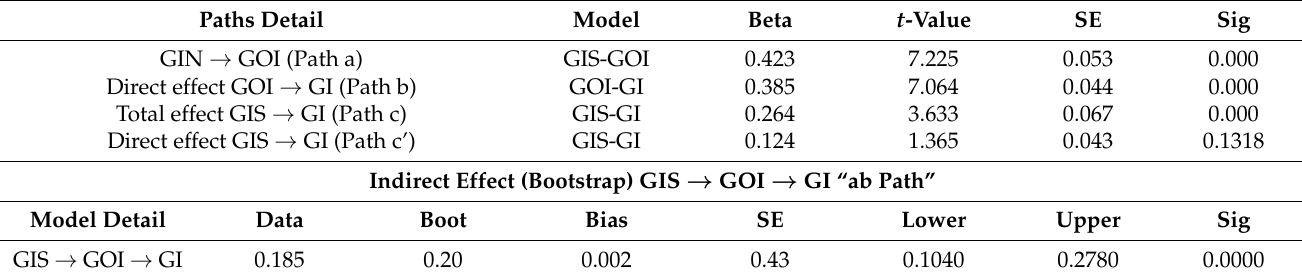
Table 5. Results of Mediation Analysis GIS → GOI → GI.